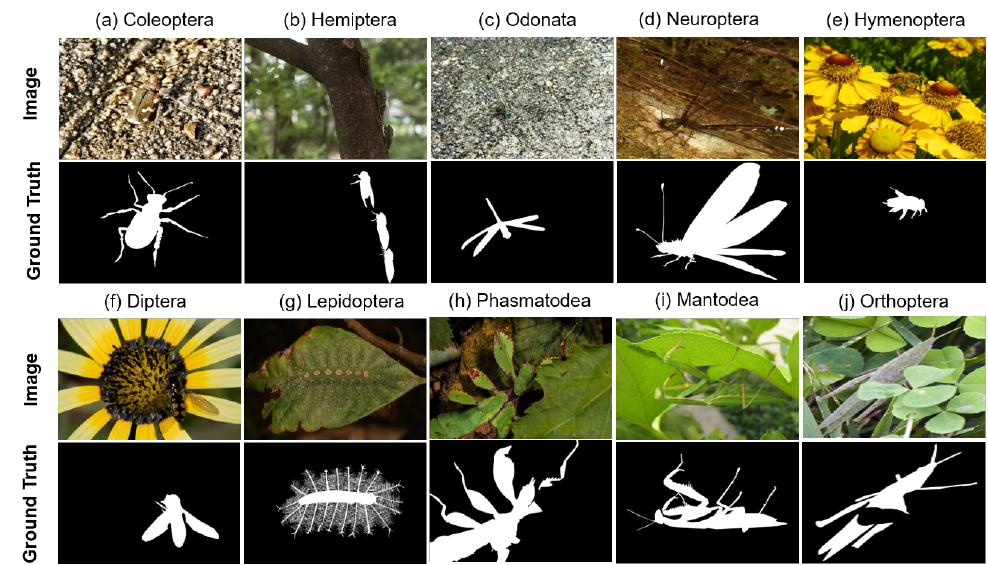
Figure 3. Examples of ecological image and ground truth pairs.